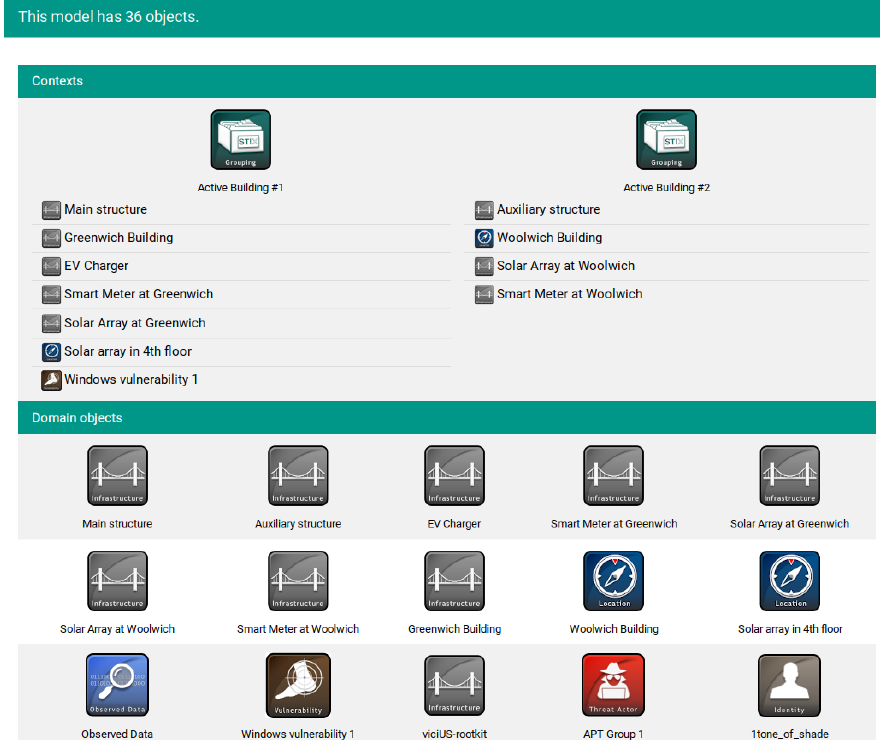
Figure 6. Base STIX model for active buildings in the dashboard of